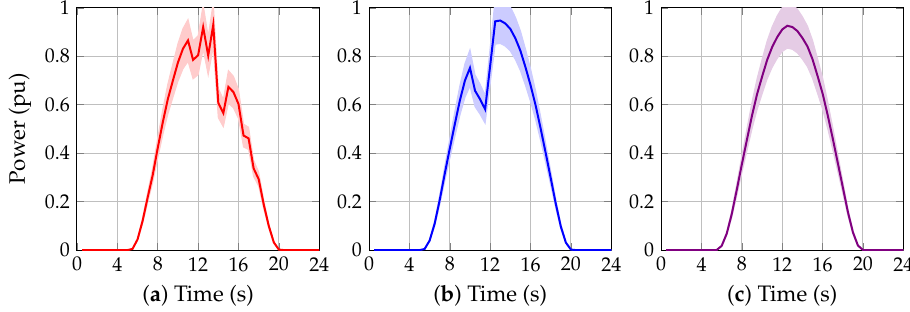
Figure 4. Power available for the PV generators with Uncertainty ± 10%: ( a ) PV generator connected to node 3, ( b ) PV generator connected to node 11, and ( c ) PV generator connected to node